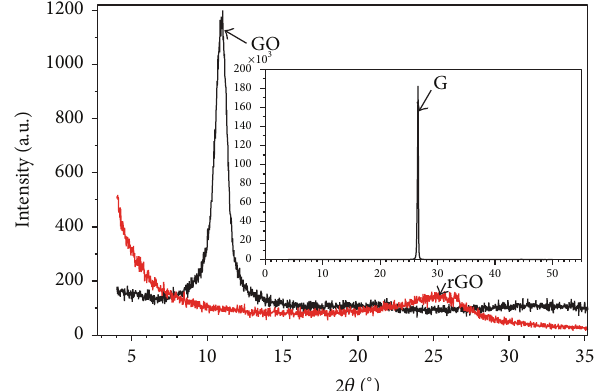
Figure 4: XRD spectra of graphite (G), graphene oxide (GO), and reduced graphene oxide (rGO).